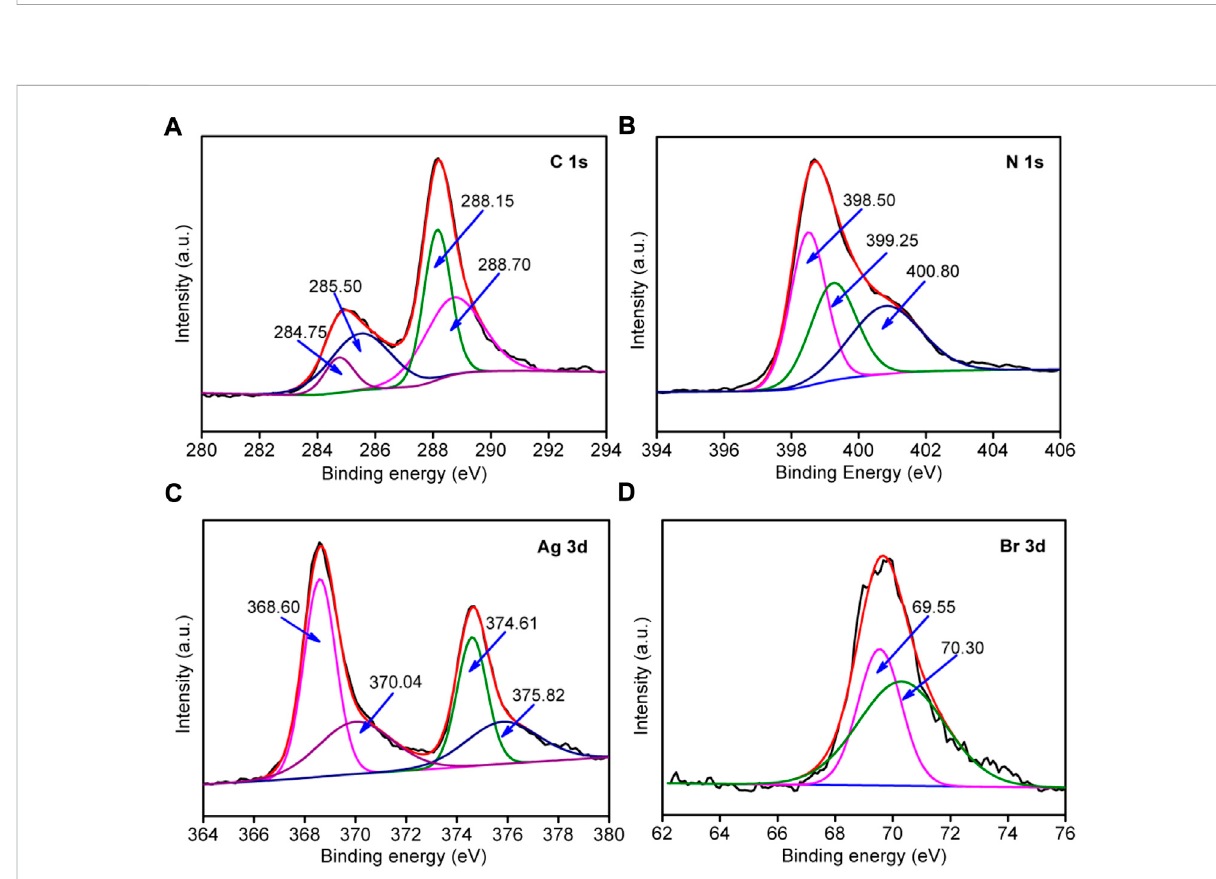
FIGURE 5 High-resolution XPS spectra of g-C 3 N 4 /Ag/AgBr-8% for C 2p (A) , N2p (B) , Br 1s (C) , and Ag 3d (D)